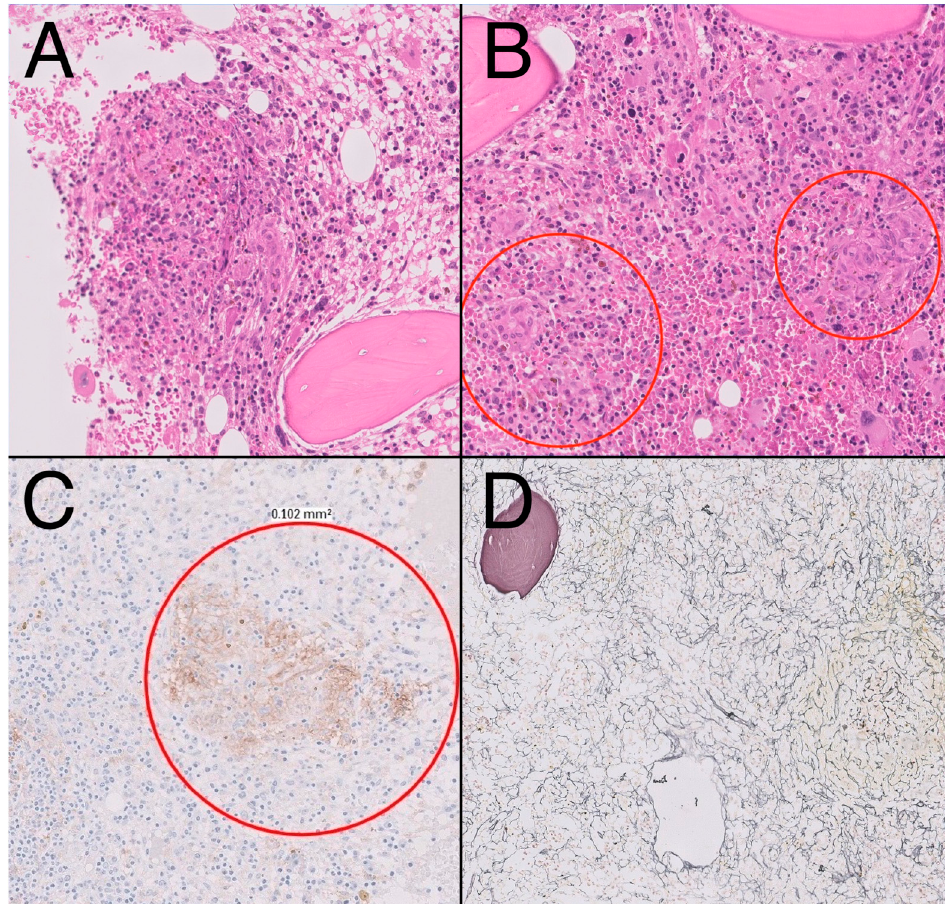
Figure 4. Histology of bone marrow. Circled granulomas are shown in different stains: hematoxylin–eosin (20 × ) ( A , B ) and CD11c (10 × ) ( C ). Reticulin staining showing grade 2 bone marrow fibrosis (10×) ( D ).